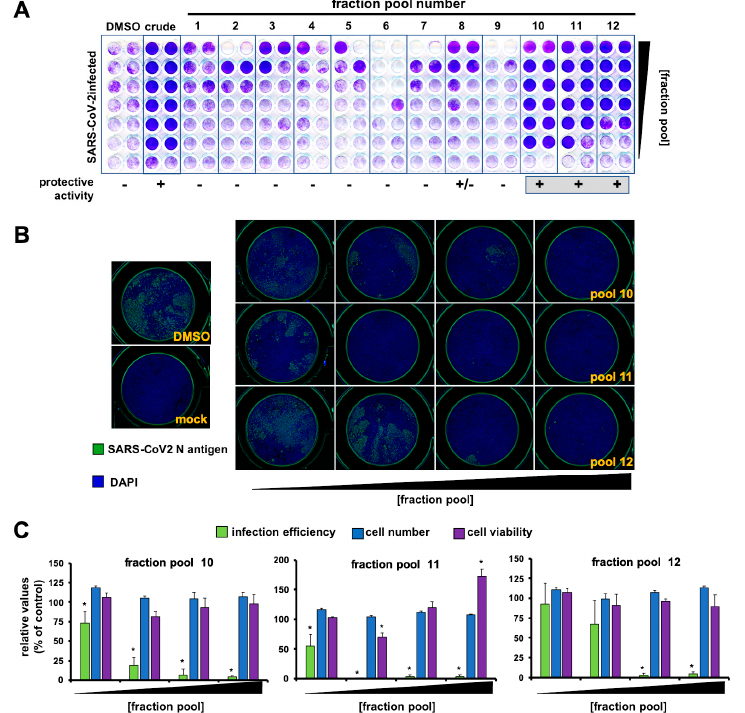
Figure 2. Extract fractionation and identification of antiviral fraction pools. ( A ) Vero E6 cells were inoculated with SARS-CoV-2 (MOI = 0.001) in the presence of serial 2-fold dilutions of vehicle (DMSO), a crude Marchantia extract and the fraction pools. Inoculated cultures were incubated for 72 h, time after which they were fixed and stained with a crystal violet solution. Mock-treated cells were used as the control of the integrity of the cell monolayer (non-infected). ( B ) Vero E6 cells were inoculated (MOI = 0.01) in the presence of serial dilution of the fractions and incubated for 24 h before fixation; processing for immunofluorescence microscopy and cytotoxicity assays was as described in the materials and methods section. Representative images of the fraction pool cell-based evaluation are shown. ( C ) Quantitation of infection efficiency, cell number and cell viability. These data are shown as average ( ± SD) of three biological replicates. Statistical significance was estimated using one-way ANOVA (Dunnet ´ s post hoc test, * p <